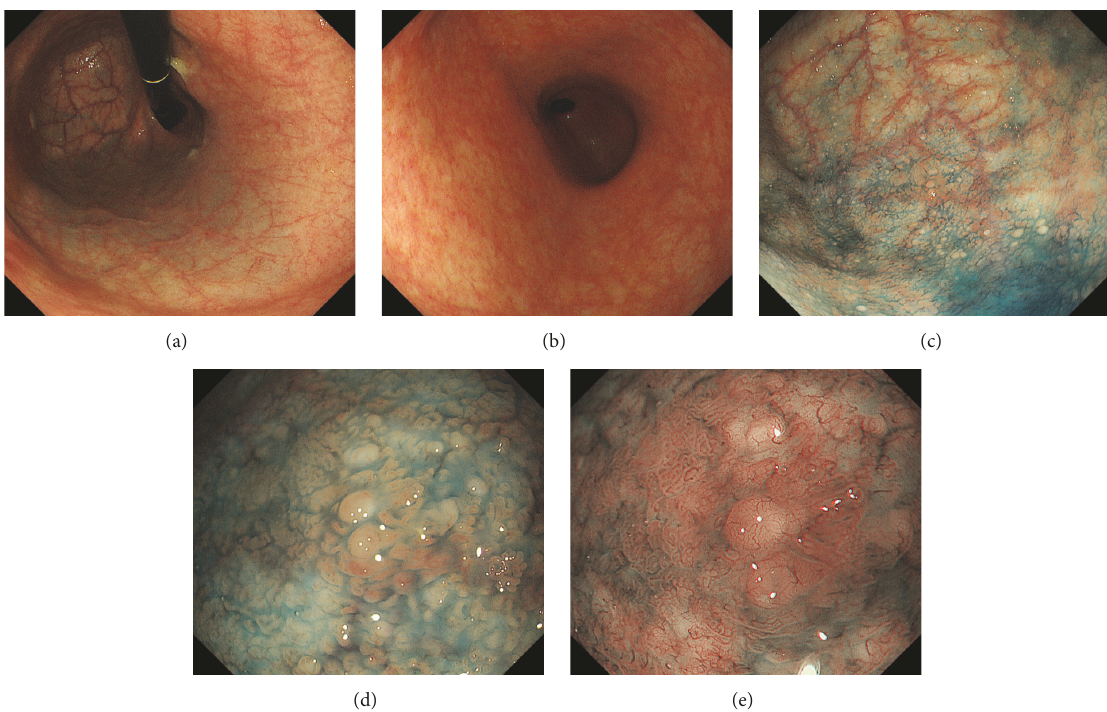
Figure 3:Esophagogastroduodenoscopy images of Case2. Atrophy is moreprominentin the fornix (a),compared tothe antrum(b). Multiple white substances are seen in the gastric fornix and in the body after indigo carmine spraying (c, d). Microvasculature is also observed on magnified observation with narrow-band imaging